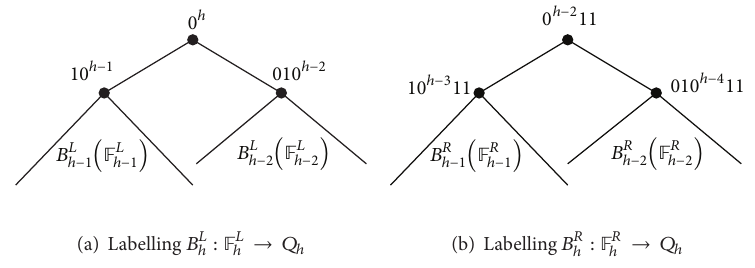
Figure 4: Embedding F 𝐿 4 and F 𝑅 4 in 𝑄 4 .